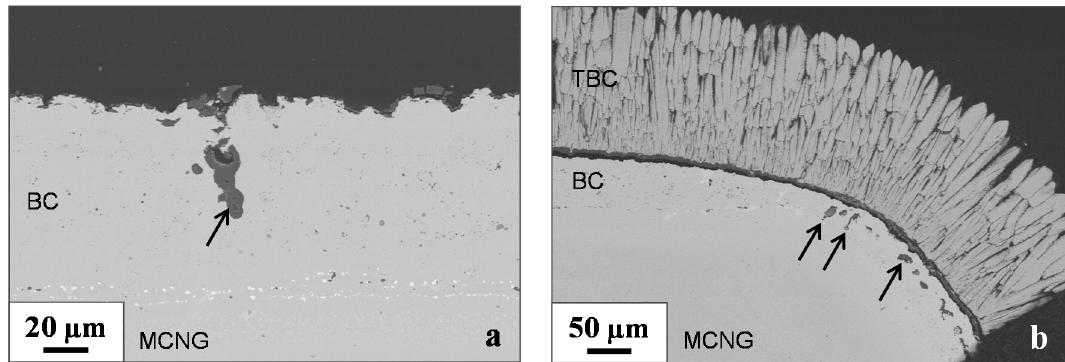
Figure 8. Cross-sections of the MCNG-Trib-Pt/2 TBC system after 300 cycles. The arrows identify zones of oxide penetration within the bond-coating, ( a ) on one sample face, ( b ) on one sample corner. Thermal cycles of 1 h at 1100 °C, with a high-flow air cooling. SEM images in BSE mode.